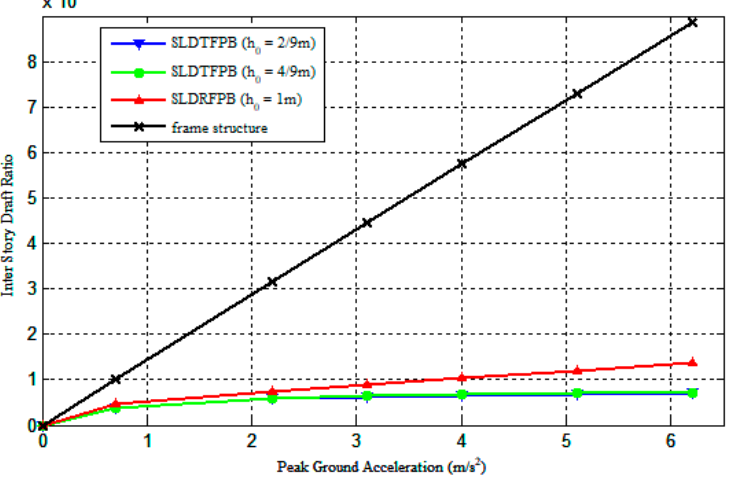
Figure 14. Inter-story drift ratios of isolation structures equipped with SLDTFPB or SLDRFPB.